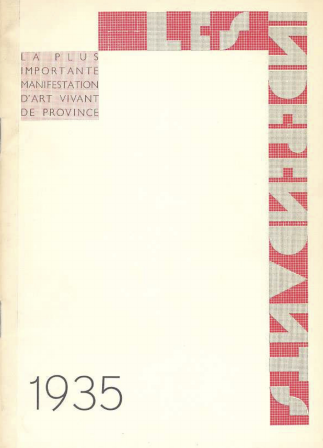
Figure 5. Front cover of the 8th SAIB exhibition catalogue, 1935.